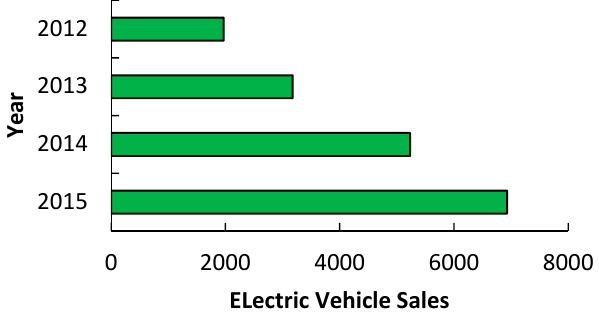
Figure 9. EV sales in Canada from 2012 to 2015.